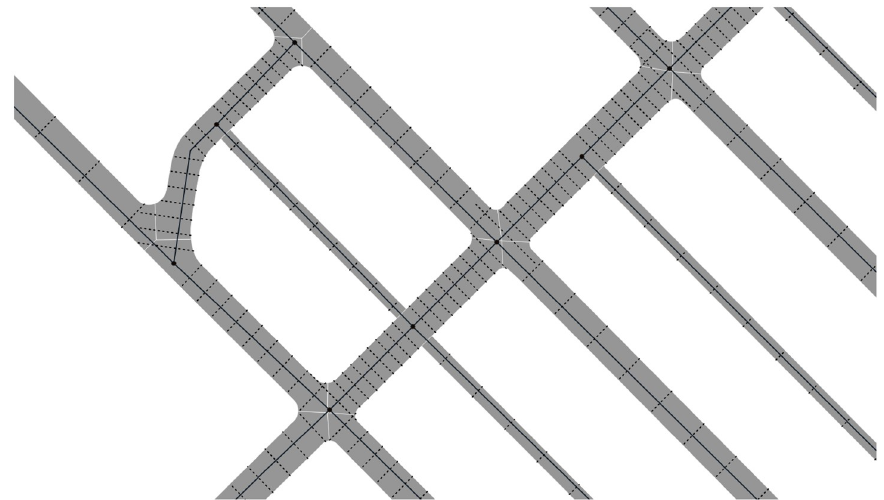
Fig 4. Lines used to calculate the road width (excerpt of Toronto). For every centreline (black solid line) there are nine perpendicular lines (black thin dotted lines) that are created, which are intersected with the polygons of the roads so that their length can be used to measure the width at the specific point.